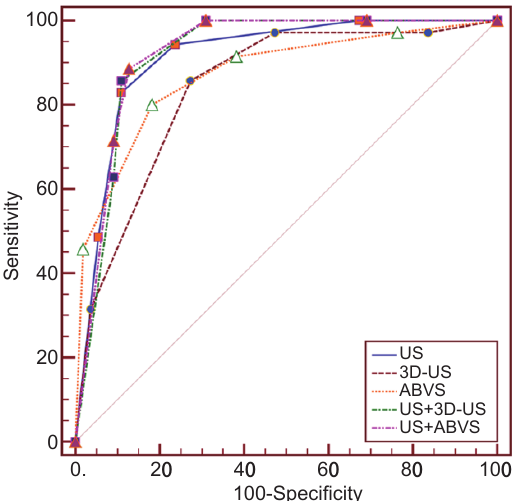
Figure 4 The receiver operating curves (ROC) of conventional US, 3D- US, ABVS individually and 3D-US combined with US, ABVS combined with US. US, ultrasound; 3D-US, three-dimensional US; ABVS, automated breast volume scanner.